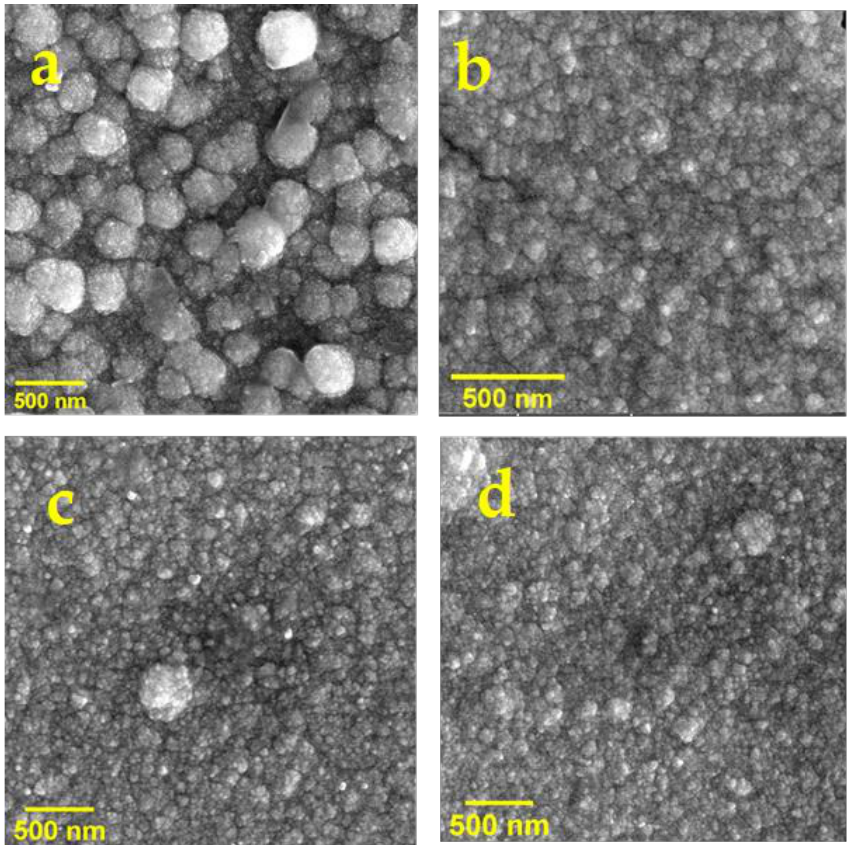
Figure 7. SEM photographs for ( a ) as-deposited, and annealed thin films at ( b ) 20 min, ( c ) 40 min, and ( d ) 60 min.